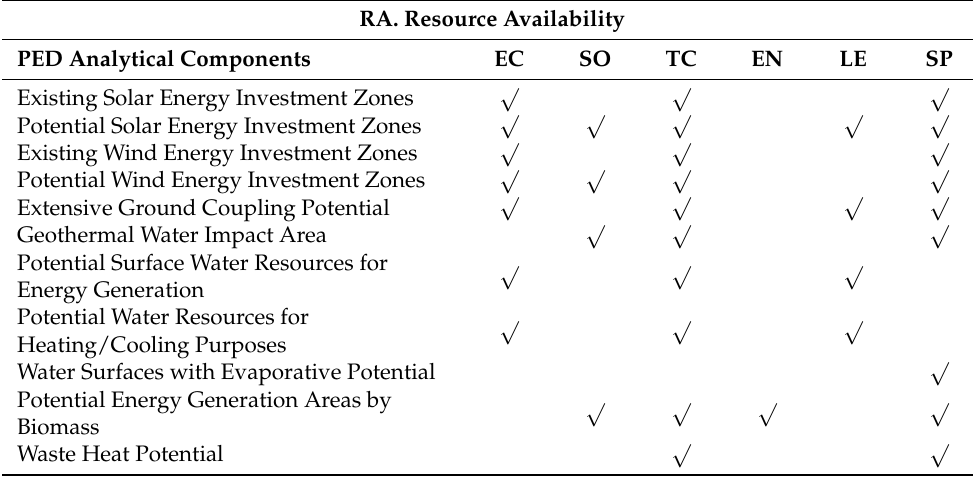
Table 7. Criteria considered for resource availability PED analytical components analysis.